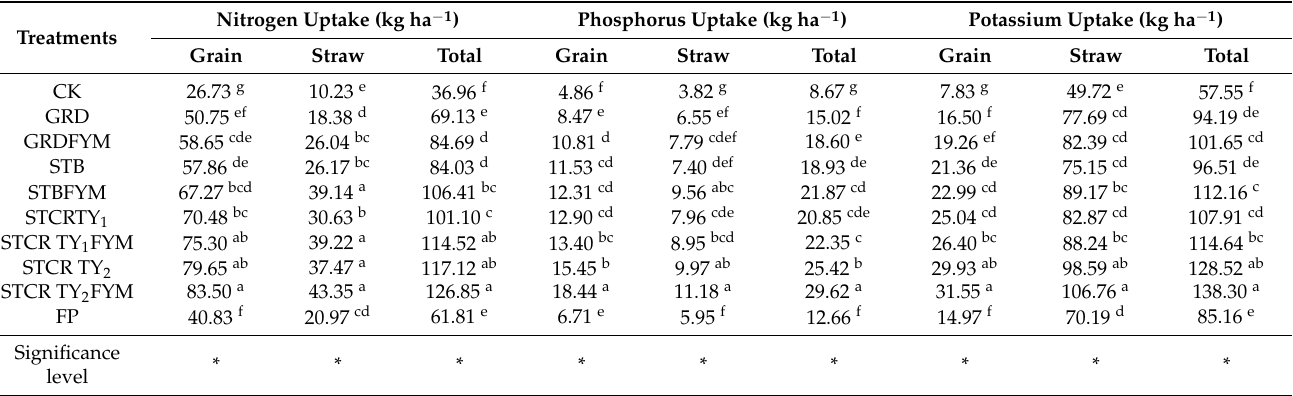
Table 8. NPK uptake by DSR under different